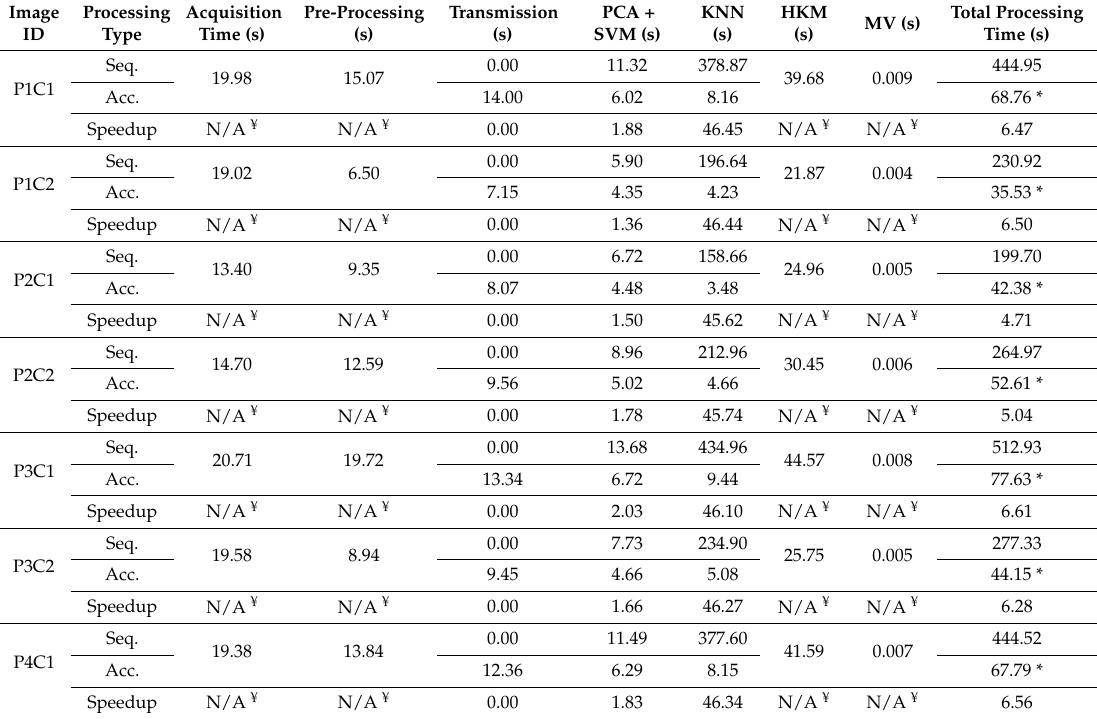
Table 3. Acquisition and processing time comparison between the sequential (Seq.) and accelerated (Acc.) implementations of the proposed algorithm for different size of